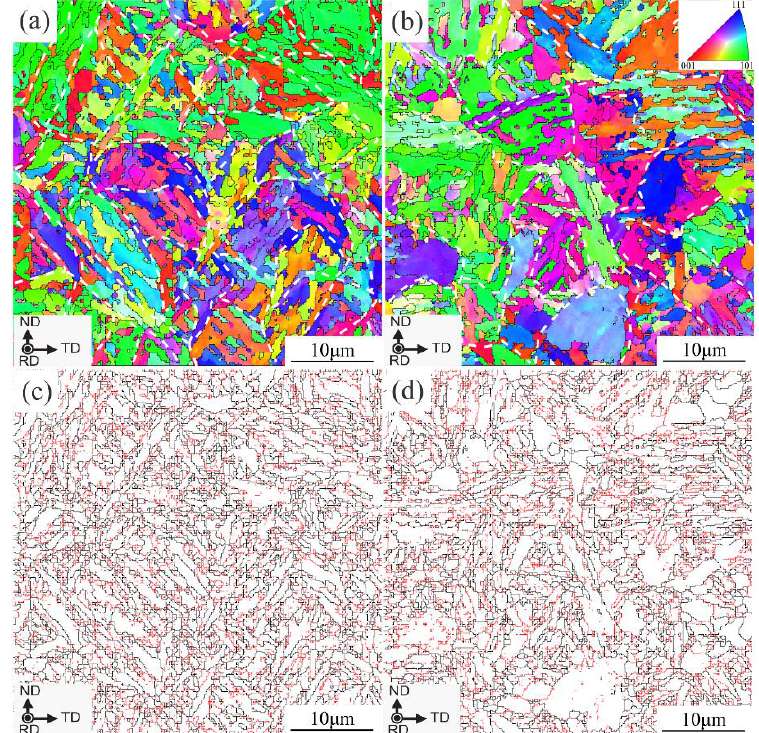
Figure 5. Microstructures of the quenched samples at 850 ◦ C, ( a , c ) oxide addition, ( b , d ) conventional. The black and red lines in the image quality map ( c , d ) represents high angle boundaries of θ ≥ 15 ◦ and low ones of θ < 15 ◦ , respectively. RD means the rolling direction of the steel, TD the transverse direction and ND the normal direction.